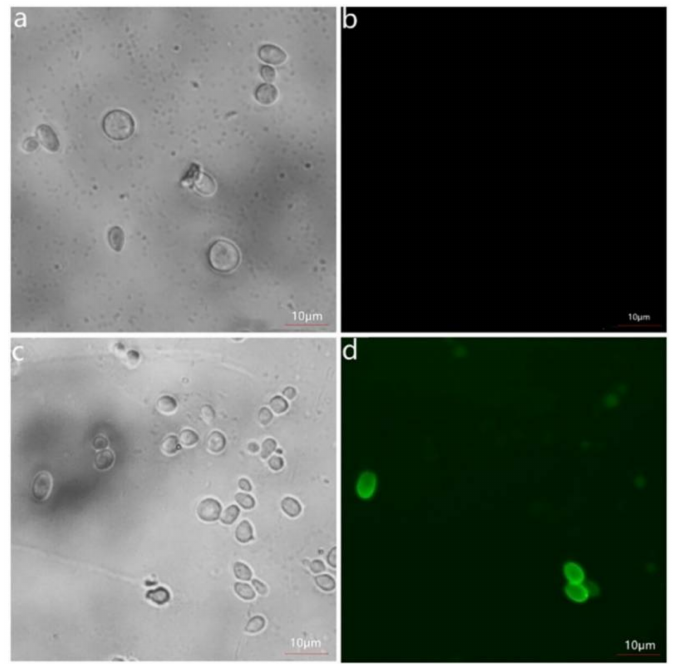
Figure 2. Immunofluorescence labeling of recombinant enzyme displayed on the yeast cell surface. ( a , b ) the bright-field and immunofluorescence micrographs of S. cerevisiae EBY100 cells harboring pYD1, respectively; ( c , d ) the bright-field and immunofluorescence micrographs of S. cerevisiae EBY100 cells harboring pYD1-levU, respectively.